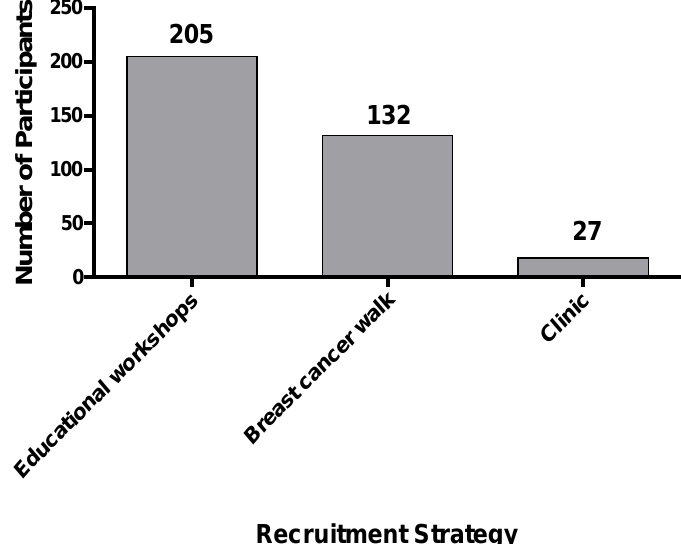
Figure 1. Strategies to recruit African American women in the Stand for breast cancer genetic Research (STAR) study.